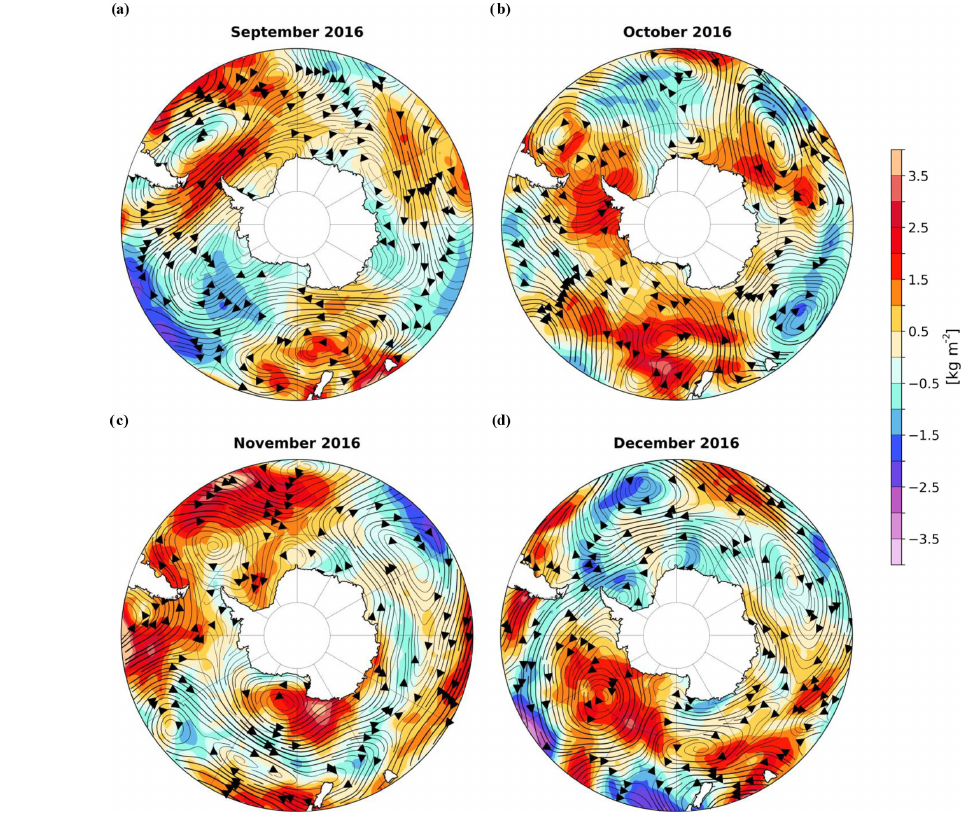
Figure 3. The vertical integral of water vapor anomalies (IWV, shaded areas) and the vertically integrated water vapor transport (WVT, streamlines) from September until December 2016. The anomalies are computed relative to the reference period